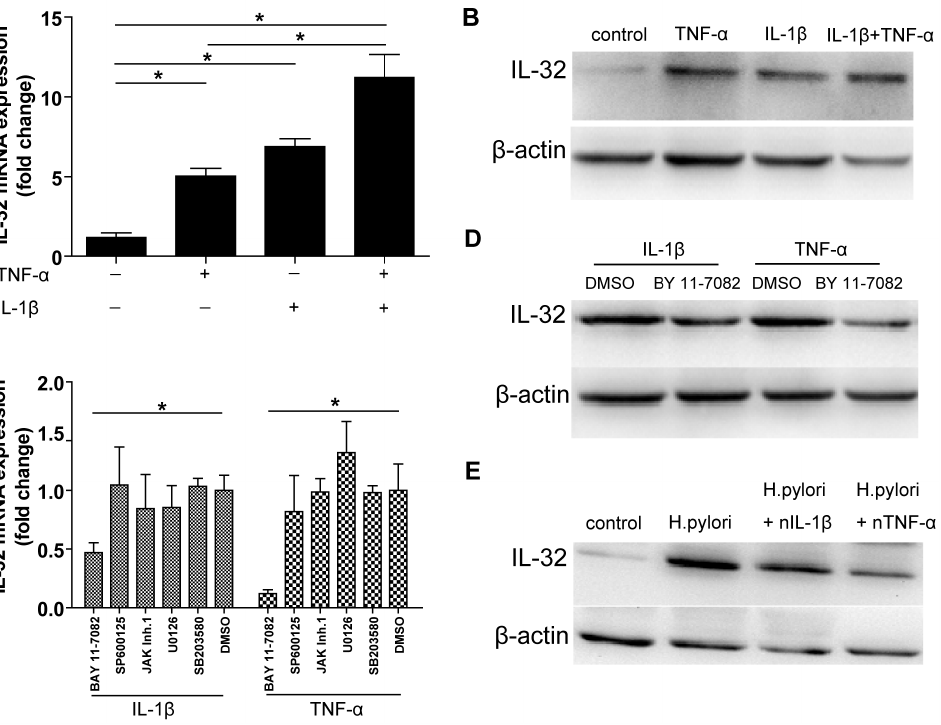
Figure 3. Induction and regulation of IL-32 mRNA in AGS cells. A. IL-32 mRNA expression was analyzed in AGS cells after stimulation with TNF- a and/or IL-1 b for 24 hours. * P , 0.05; B. IL-32 protein expression was detected by Western blot from (A); C. AGS cells were pretreated with 10 m M NF- k B inhibitor (BAY 11-7082), MEK1/2 inhibitor (U0126), p38/MAPK inhibitor (SB203580), JNK inhibitor (SP600125), JAK inhibitor I or the vehicle DMSO for 1 hour prior to IL-1 b or TNF- a stimulation. IL-32 mRNA level was determined by real-time PCR. * P , 0.05 versus the vehicle DMSO treated cells; D. The level of IL-32 protein was detected after AGS cells pretreation with 10 m M NF- k B inhibitor (BAY 11-7082) or not and then stimulation with TNF- a or IL-1 b ; E. AGS cells were infected by H. pylori at a MOI=100 for 24 hours and simultaneously treated with neutralizing antibodies to block TNF- a or IL-1 b .